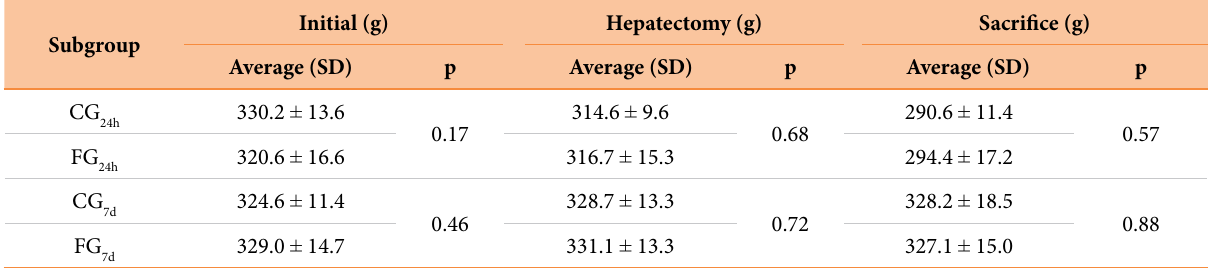
Table 1 - Body weight comparisons between control (CG) and 5-fluorouracil (FG) subgroups at chemotherapy day (initial), at the hepatectomy day and sacrifice.